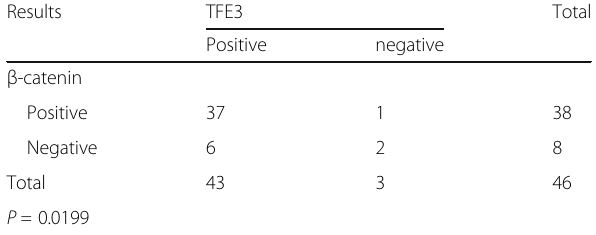
Table 3 Comparison of β -catenin and TFE3 Positivity in